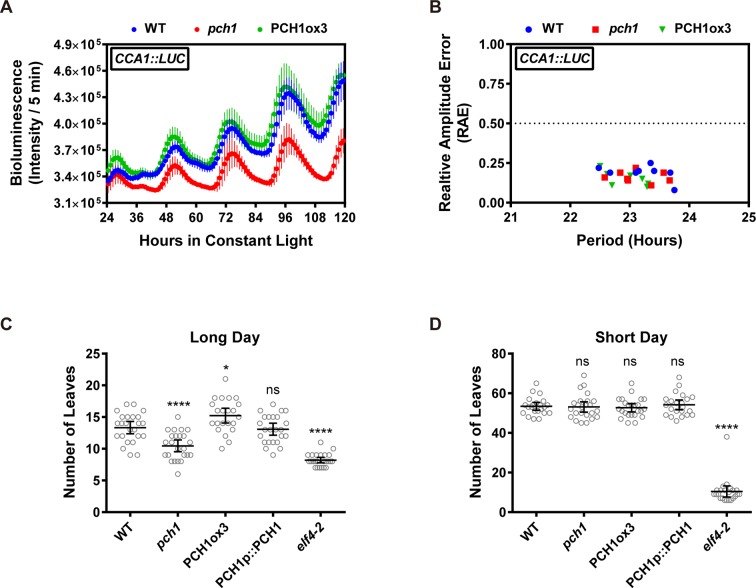
Phenotypic characterization of pch1 and PCH1ox3 in circadian and flowering pathways.(A) Seedlings of WT, pch1, or PCH1ox3 carrying the CCA1:LUC luciferase reporter were grown under 12L:12D conditions for five days before transferring to continuous white light. Bioluminescence were plotted against ZT hours. Mean ± SD (n = 8). Experiments were repeated at least three times. (B) Relative amplitude error (RAE) versus period of WT, pch1, and PCH1ox3 rhythms was plotted. RAE = 0.5 was used as a cutoff (dotted line), above which a seedling is not considered rhythmic (n = 8). Experiments were repeated at least three times. (C) and (D) Flowering assays under either long day (C) or short day (D) conditions were conducted. Number of rosette leaves from WT, pch1, PCH1ox3 and PCH1p::PCH1 plants with 1 cm inflorescence stem was counted. Mean ± 95% CI (n ≥ 20). One-way ANOVA and multiple comparisons were done, with star symbols indicating if it is significantly different from WT (*p=0.012, ****p<0.0001, ns = not significantly different). Experiments were repeated twice.